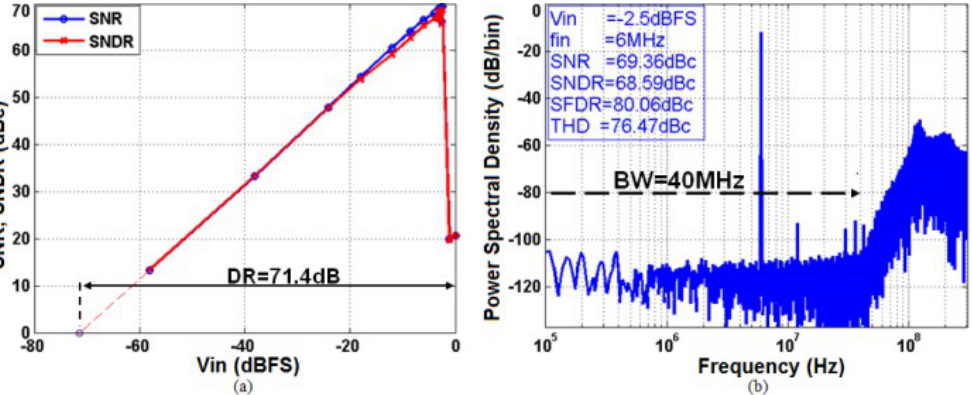
Figure 10. ( a ) PSD of the ∆Σ modulator output (65536 FFT points). ( b ) Measured SNR and SNDR as a function of the input signal level (finput = 6